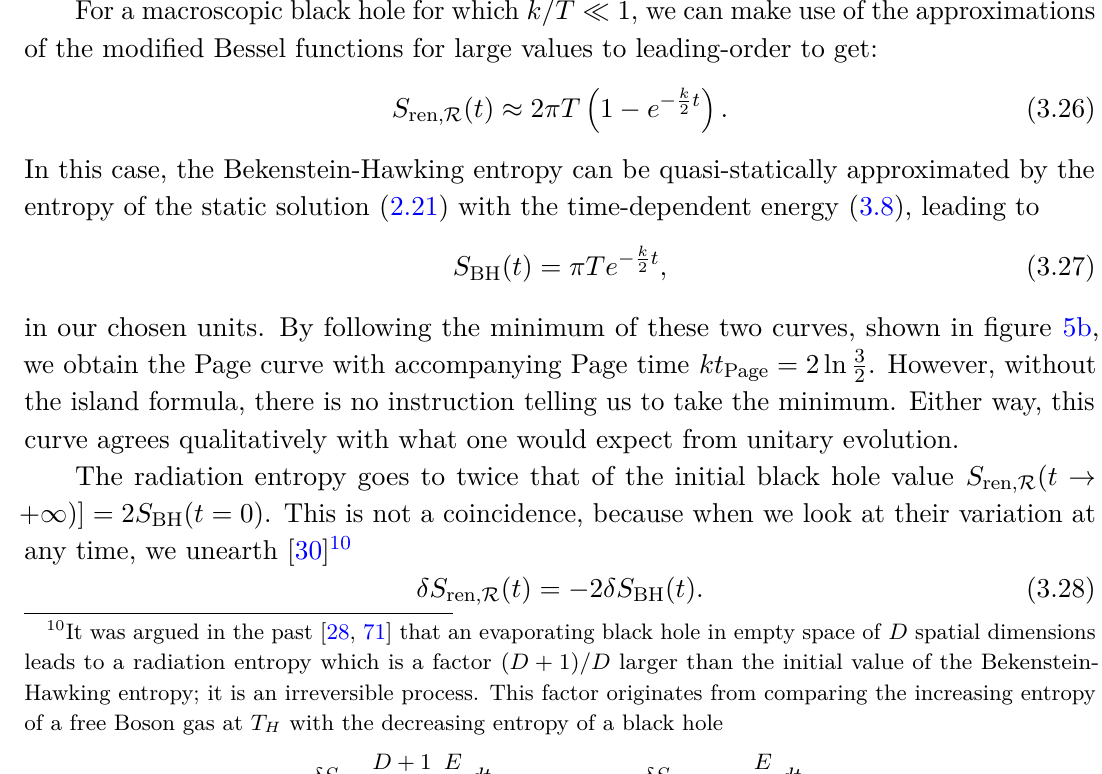
Figure 5 . (a) The renormalised radiation entropy (3.24) for k = 1 and T = 1 and asymptotes to the value given by (3.25). (b) Following the minimum of S S BH ( t ) (3.27) results in the Page curve, here drawn for k = 0 . 01 . Also note how the radiation asymptotes to twice the initial black hole